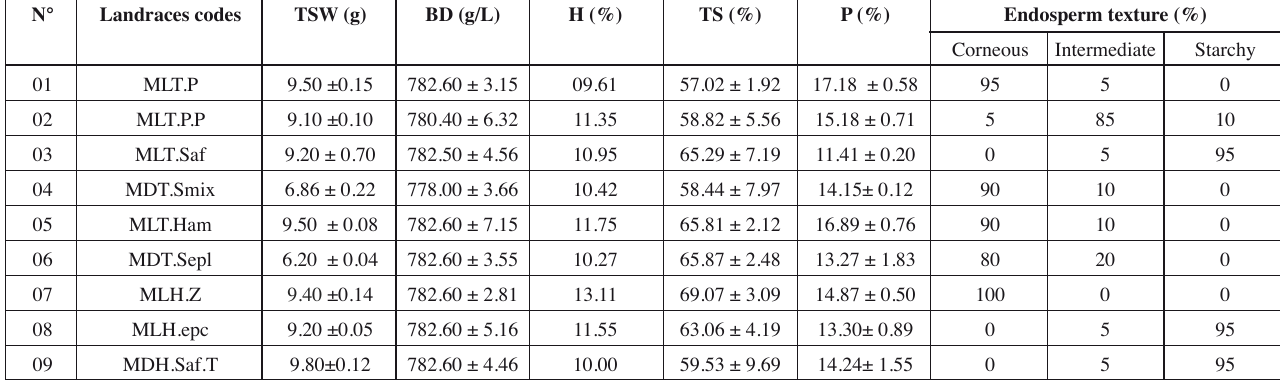
MLT.P : Pearl Millet Local fromTidikelt, MLT.P.P : Pearl Poilue (Hairy), MLT.Saf: Safra(Yellow), MDT.Smix: Domesticated from Soudan mix, MLT.Ham: Hamra(Red), MDT.Sepl: Soudan epi log (Tall Panicle), MLH.Z: Millet Local from Hoggar. Zarga (Blue), MLH.epc : Local Hoggar epi court (Short panicle), MDH.Saf.T : Domesticated Hoggar Safra (Yellow) from